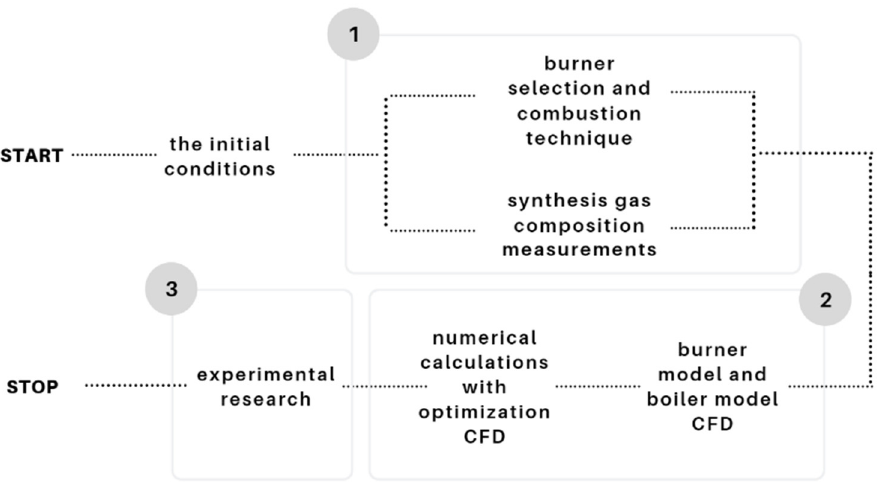
Figure 1. Scheme of 3-stage, semi-empirical modelling of the boiler.